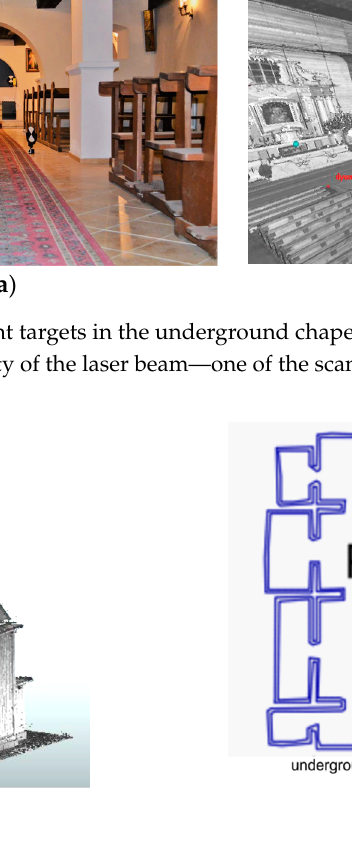
Figure 6. ( a ) Point cloud representing the church from the outside and ( b ) floor plan based on horizontal cross-sections through the point cloud.